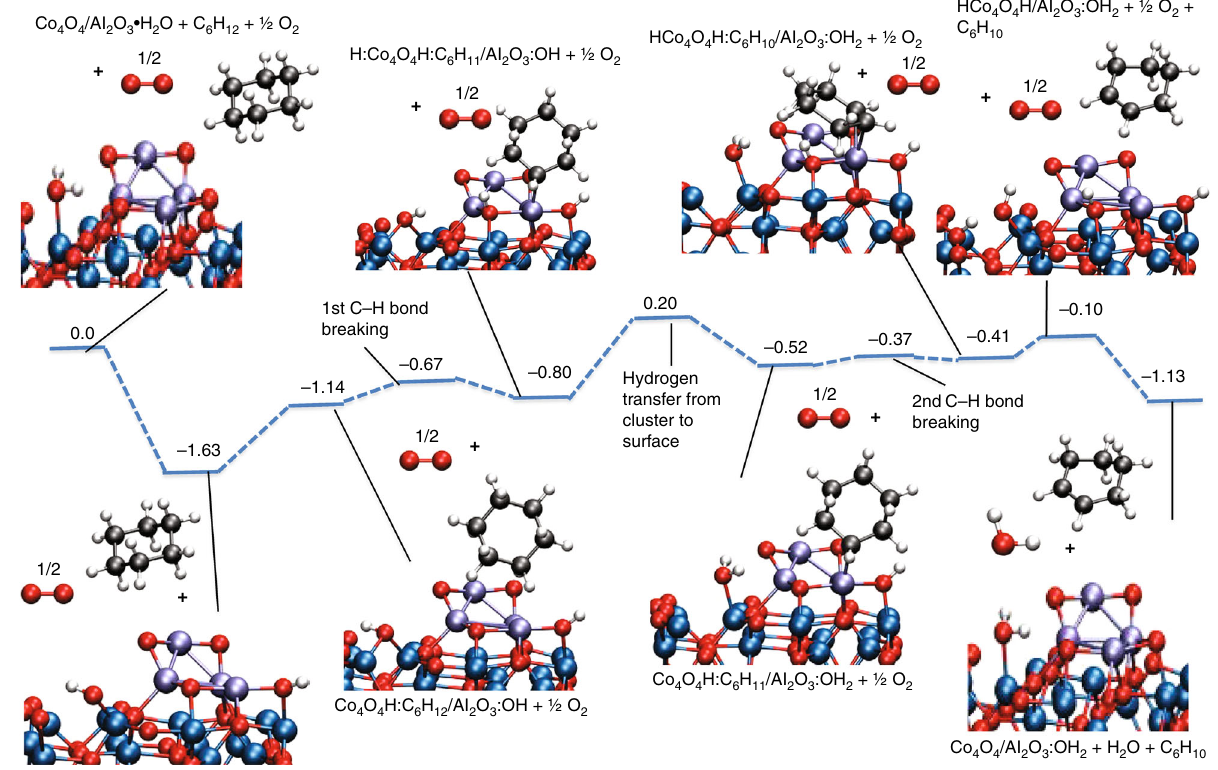
Fig. 5 Key steps leading to the formation of cyclohexene from cyclohexane on the Co 4 O 4 cluster. The values are Δ E + S trans and are in